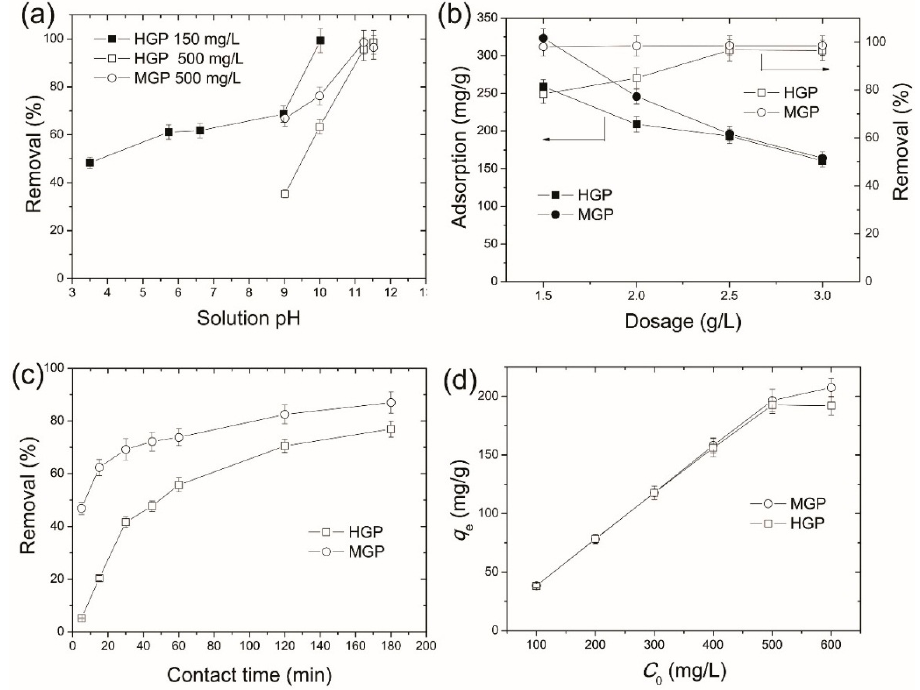
Figure 3. Effect of ( a ) initial solution pH, ( b ) dosage, ( c ) contact time (feed pH of 11, initial MB concentration of 600 mg/L, room temperature), and ( d ) initial solution concentrations on the removal of MB (feed pH of 11, dosage of 2.5 g/L, room temperature) on grape-peel based biosorbents.